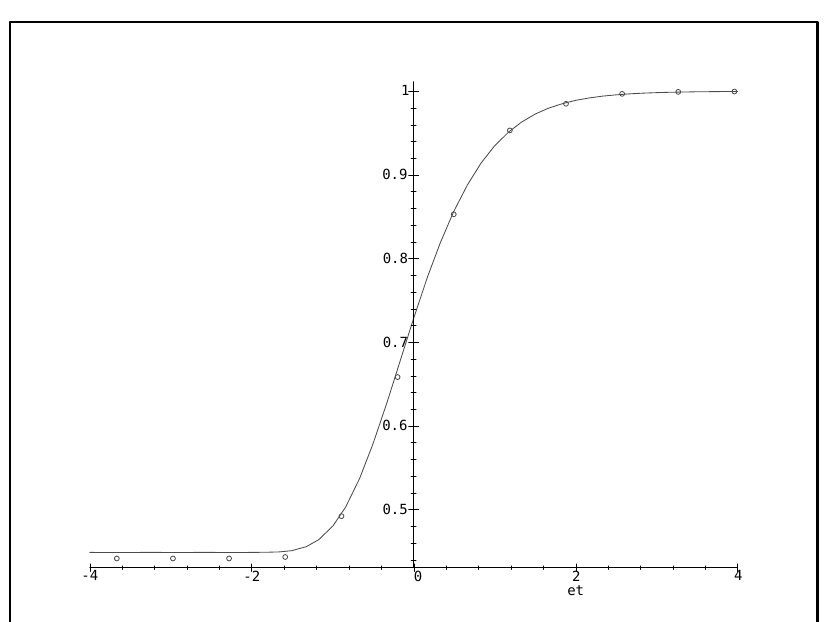
h for m (cid:5) (cid:1)